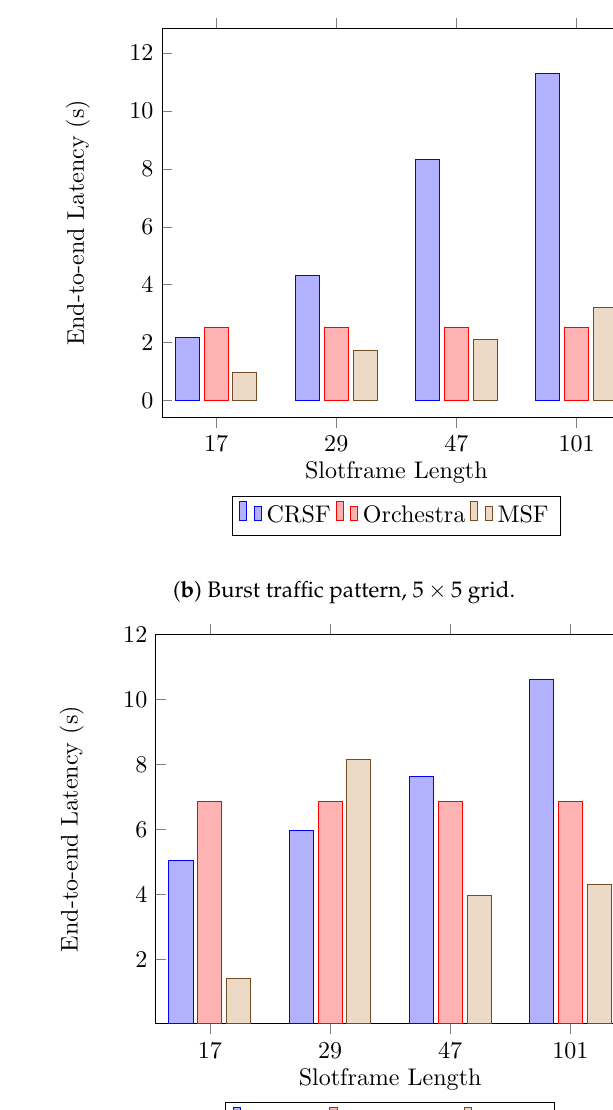
( a ) Burst traffic pattern, 4 × 4 grid. ( b ) Burst traffic pattern, 5 × 5 grid.